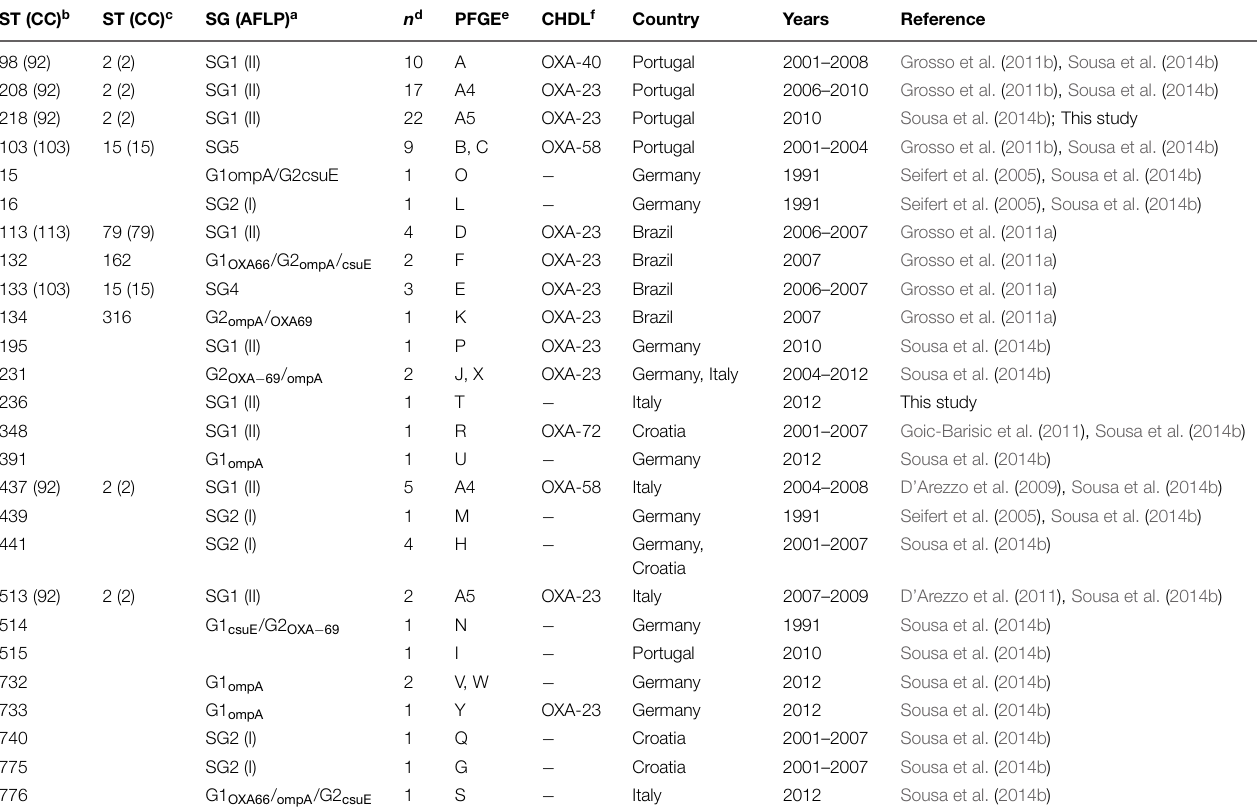
TABLE 1 | Epidemiological details of the Acinetobater baumannii isolates included in this